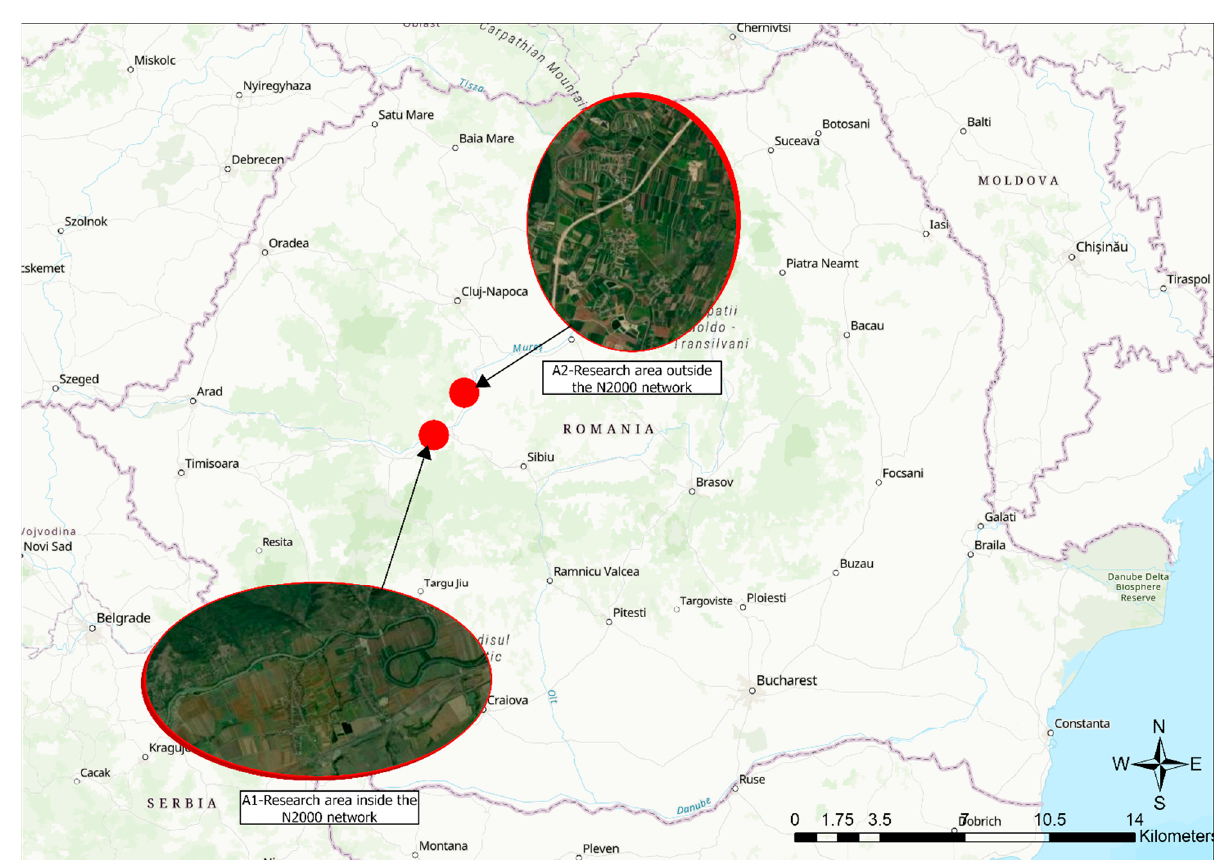
Figure 1. Location of the research areas (Source: Original).